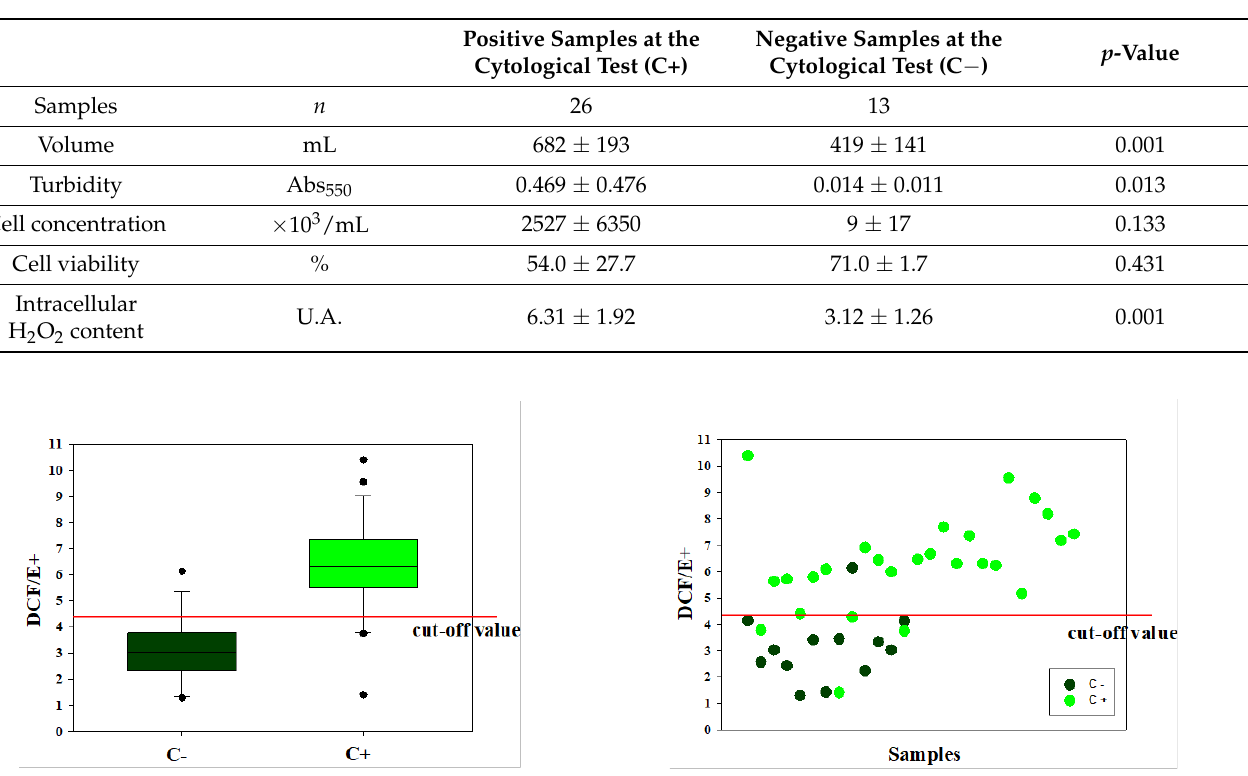
Table 1. Mean ( ± SD) values obtained from samples of uterine flushing which were positive and negative on the cytological test and related to the quantity and turbidity of the fluid recovered following the infusion of 500 mL of Ringer’s lactate as well as to the concentration, viability and H 2 O 2 content of the cells isolated from that fluid.